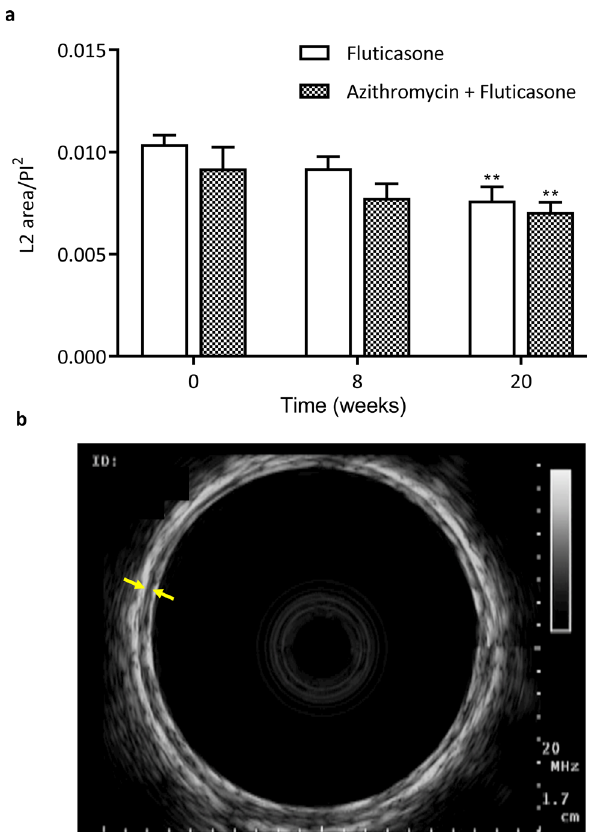
Figure 6. Endobronchial ultrasound. ( a ) Area of the second layer (L2) corrected by the internal perimeter (PI) (mean and standard error of the mean). There was a significant time main effect but no group difference with the two-way ANOVA (p = 0.0002). **p < 0.01 compared to baseline values with Dunnett’s multiple comparison tests. ( b ) Central airway obtained with endobronchial ultrasound. The distance between the yellow arrows illustrates the thickness of